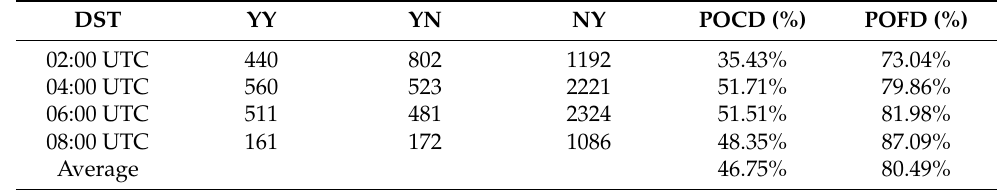
Table 6. Statistical metrics for the comparison of the DST dust identification and the PM10